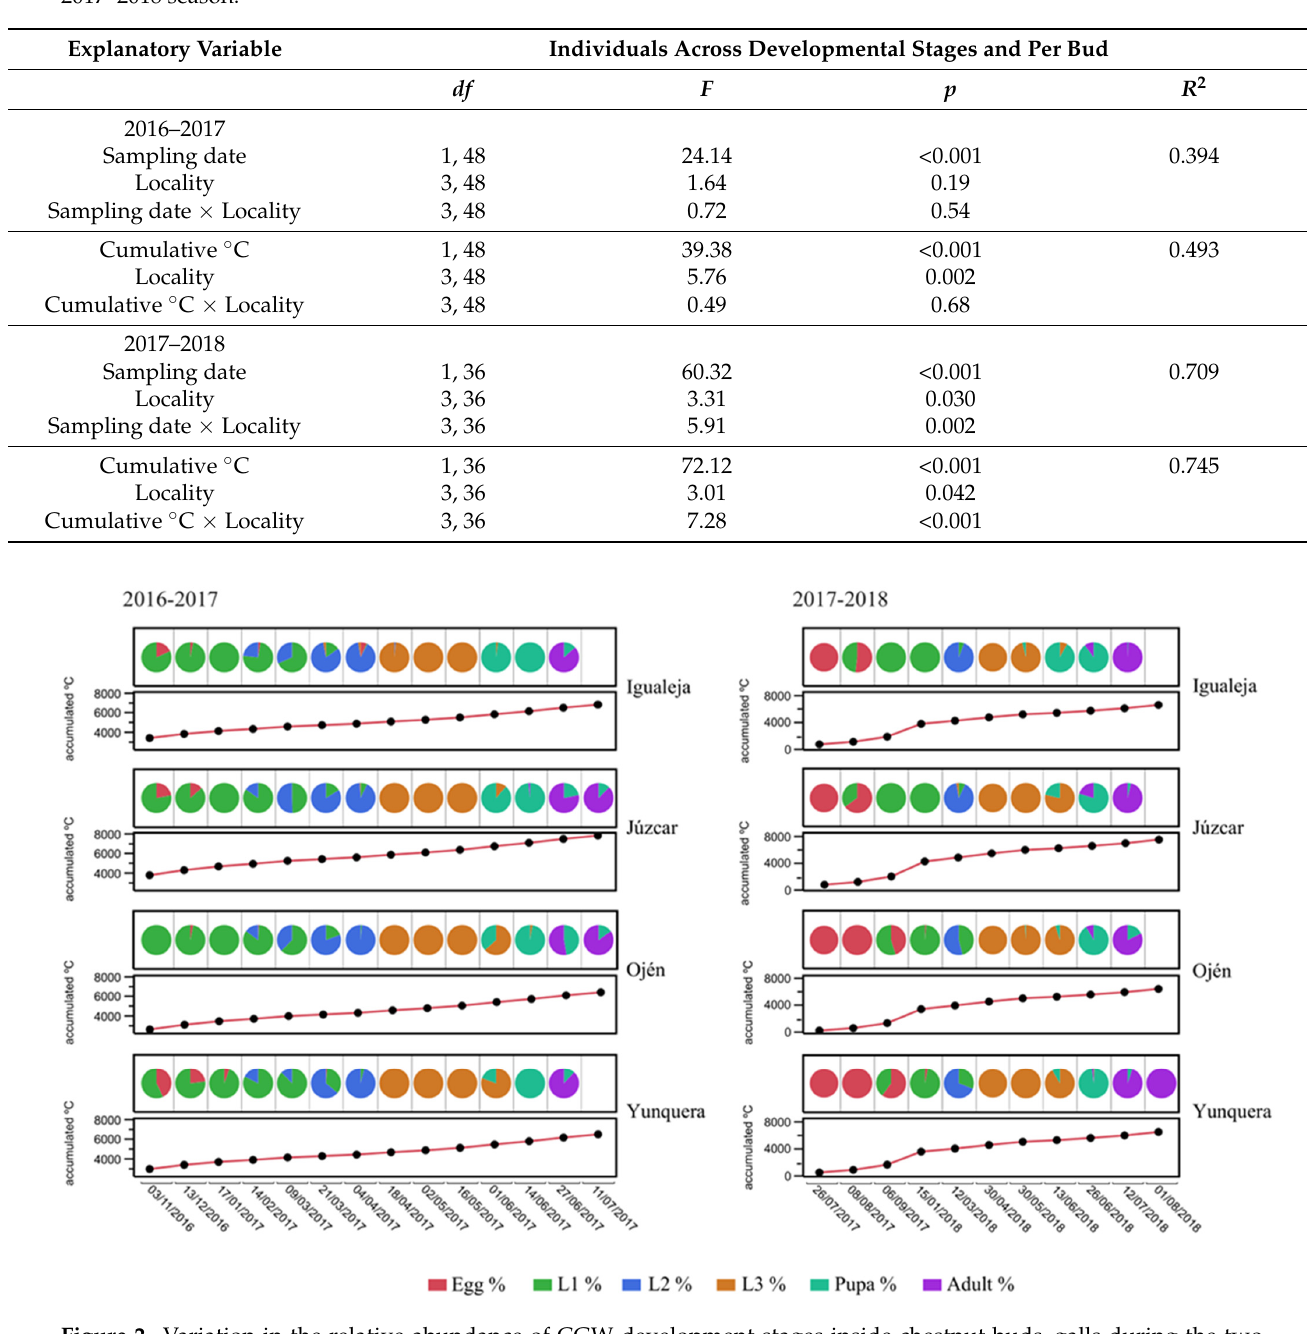
Table 2. Above, multiple response GLM results showing the effects of sampling date (or cumulative ◦ C) × locality on the number of chestnut gall wasp (CGW) per stage and bud in the 2016–2017 season. Below, the same analysis results in the